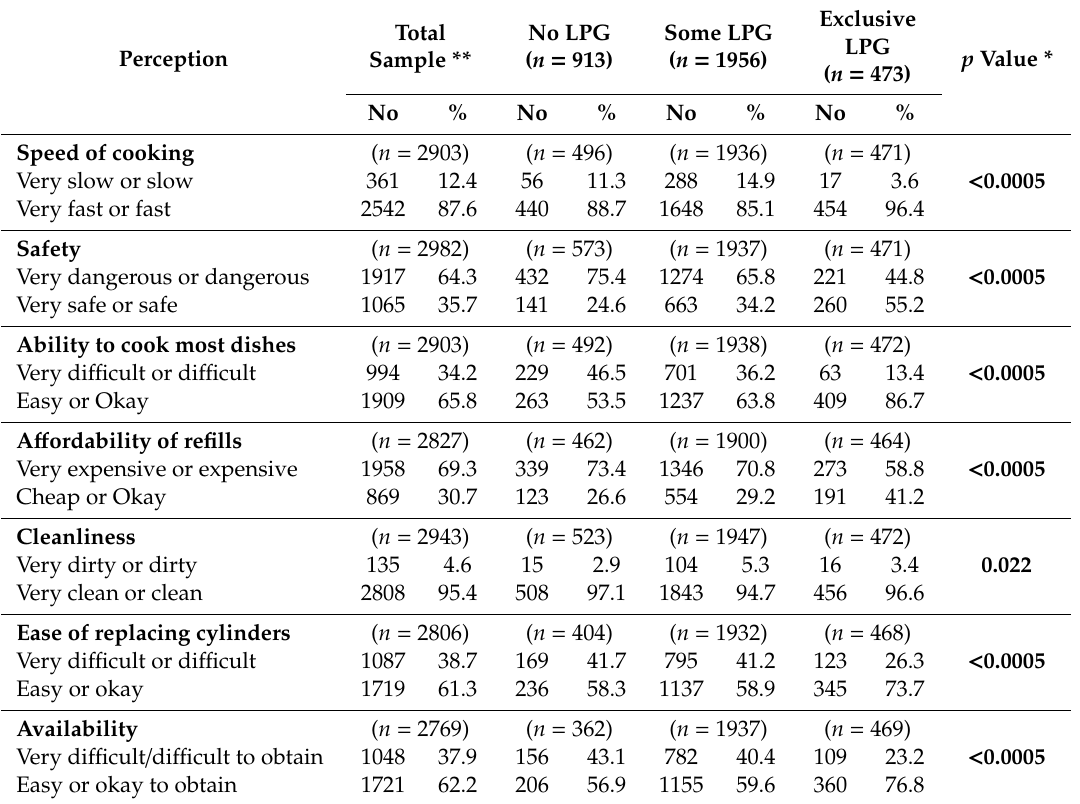
Table 5. Perceptions of LPG in seven categories across the whole sample, and according to level of LPG